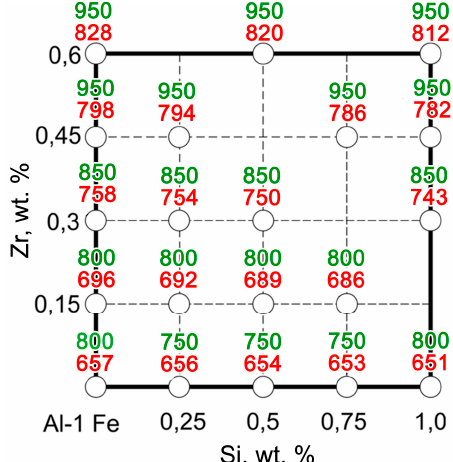
Figure 1. Quadrilateral scheme of Al-1Fe-Si-Zr.